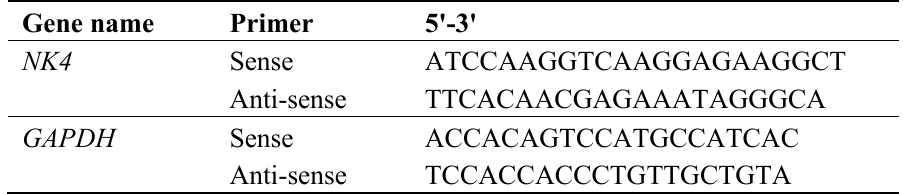
Table 1. Primer for